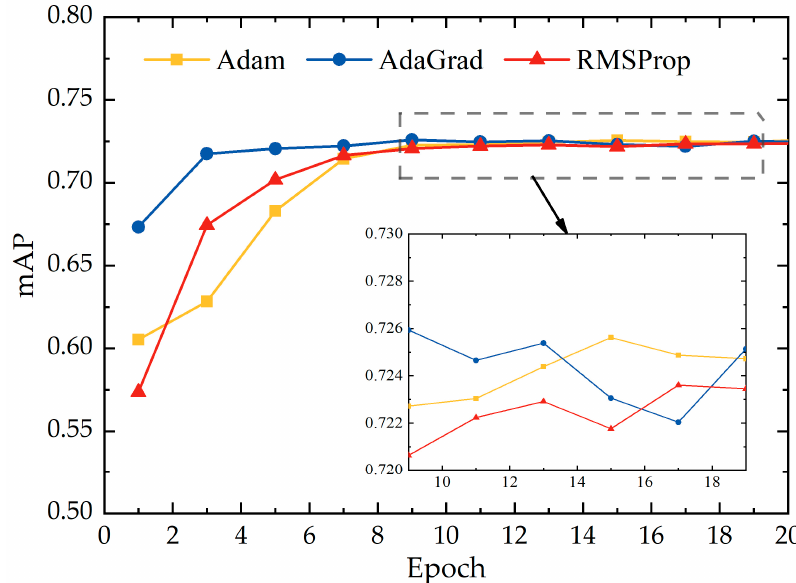
Figure 8. mAP of three